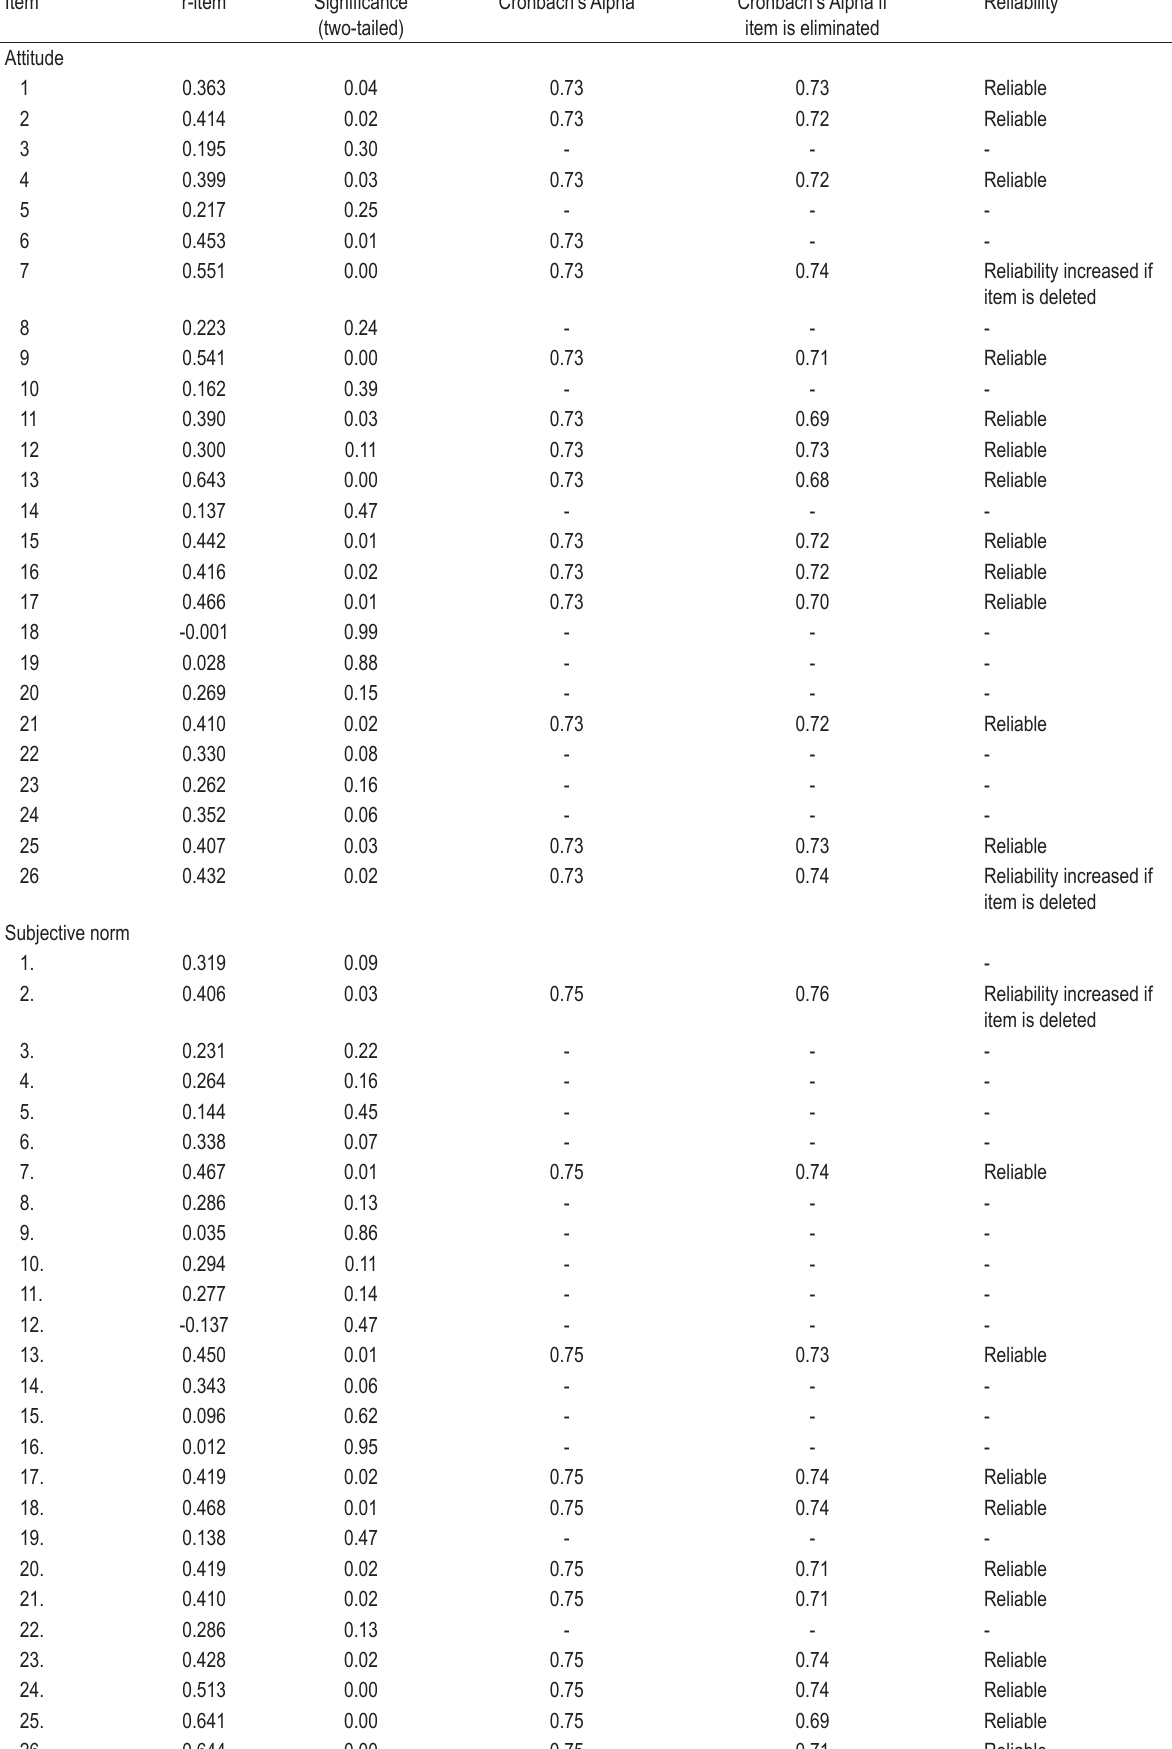
TABLE 4. Item analysis and Cronbach’s Alpha value on attitude, behavioral control, and intention